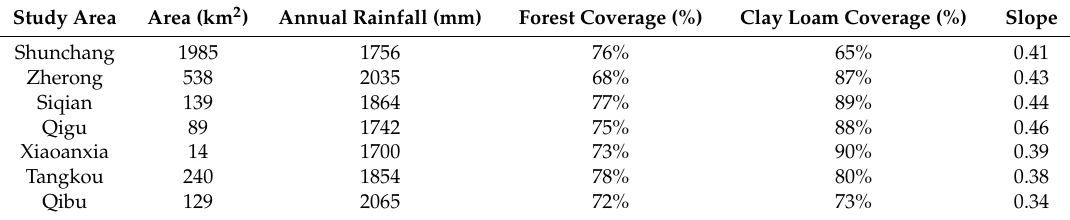
Table 1. Characteristics of the study area.